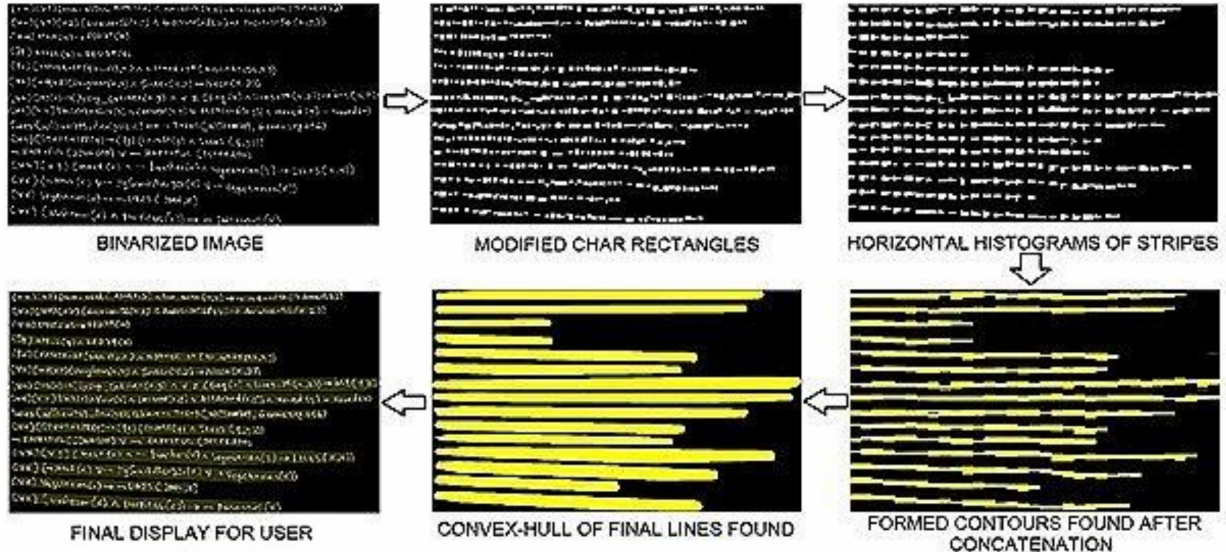
Figure 6. Basic steps of the line detection